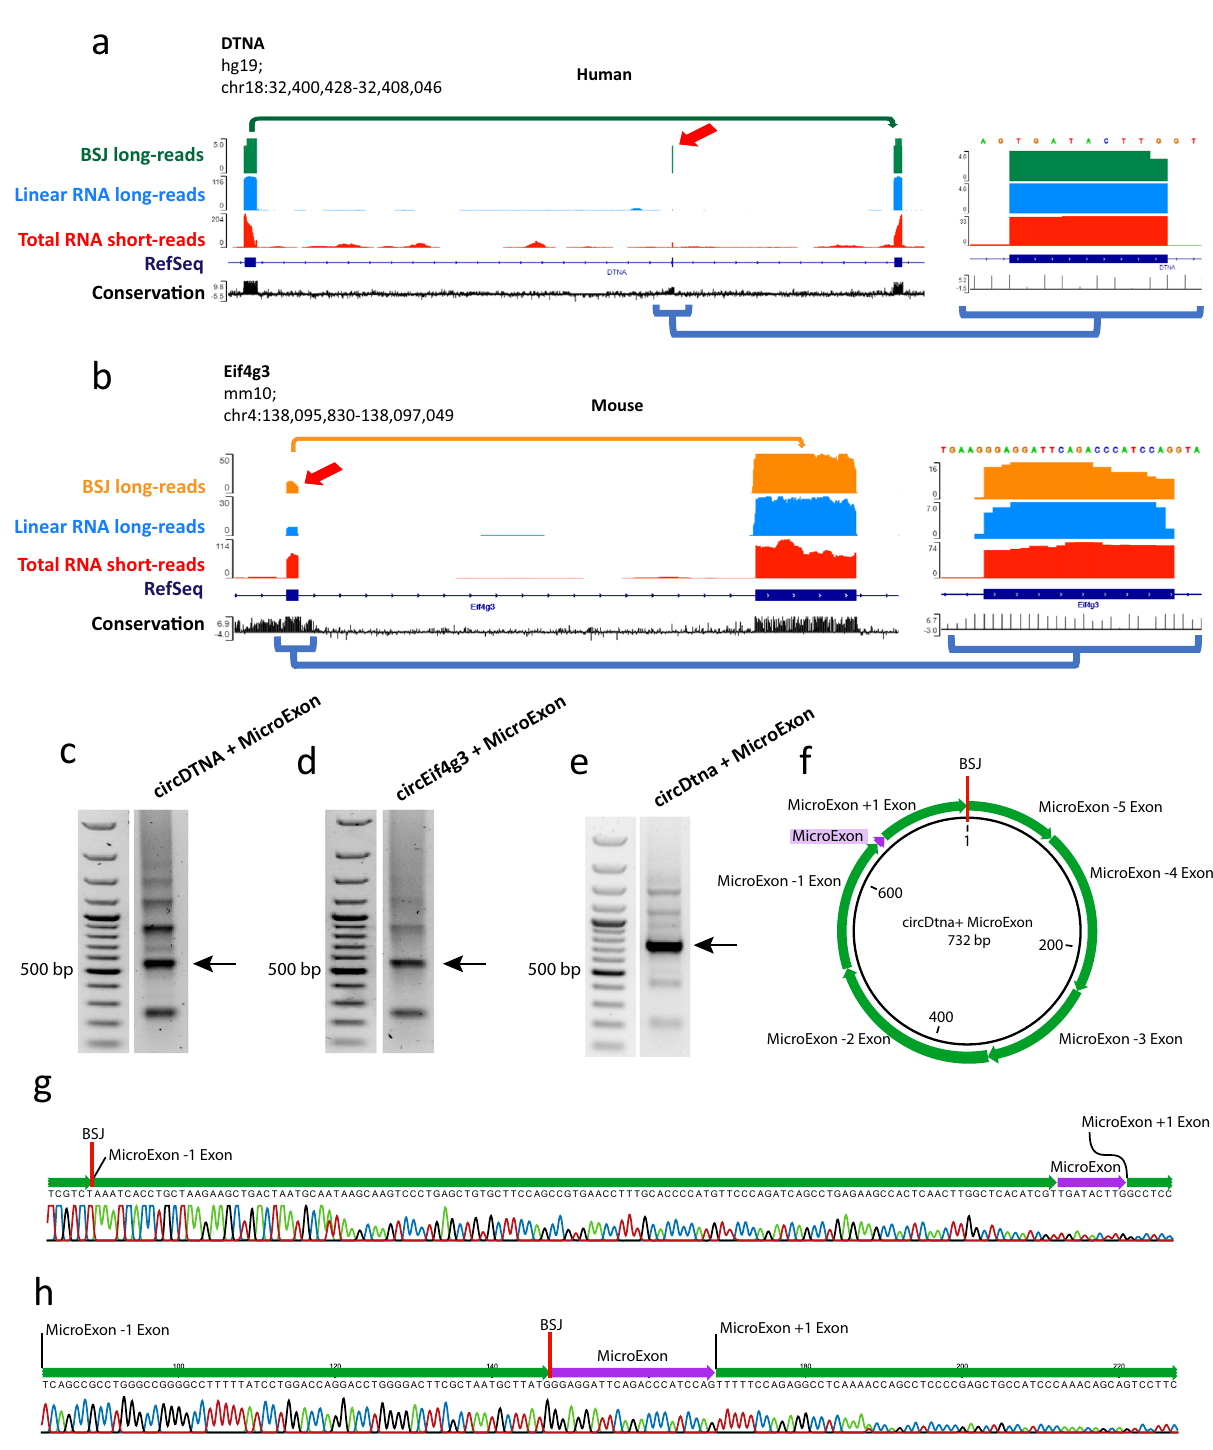
Fig. 7 Examples of microexons in circRNAs detected in BSJ-spanning long-reads. a Microexon located in circDTNA from human brain detected in 4 out of 5 BSJ-spanning reads (80%; Microexon enlarged to the right). In the long-read linear mRNA, only 4 out of 116 reads (3.5%) include the microexon with the neighboring exons. This microexon is included in 33 out of 204 reads (16%) based on short-read sequencing. b Microexon located in circEif4g3 from mouse brain detected in 16 out of 50 BSJ-spanning long-reads (32%) and 7 out of 30 reads (23%) in long-read linear mRNA. Short-read sequencing fi nd the microexon included in 74 out of 114 reads (65%). c – e RT-PCR validation of circRNAs circDTNA (shown in panel a ), circEif4g3 (shown in panel b ), and circDtna (mouse) using back-to-back primers targeting the exons neighboring the microexons and covering the BSJ. Different bands indicate several circRNA isoforms obtained from the same genomic regions and sharing the same targeted exon. Each RT-PCR has been repeated twice and resulted in the same PCR products. f Full structure determination of circDtna including the microexon using Sanger sequencing. The circRNA amplicon was gel puri fi ed from the PCR band indicated by an arrow in panel e . g , h Microexons in the RT-PCR products (marked by arrows in panels c , d for circDTNA and circEif4g3 respectively) were validated by Sanger sequencing; the individual sequencing reads cover both BSJ and the